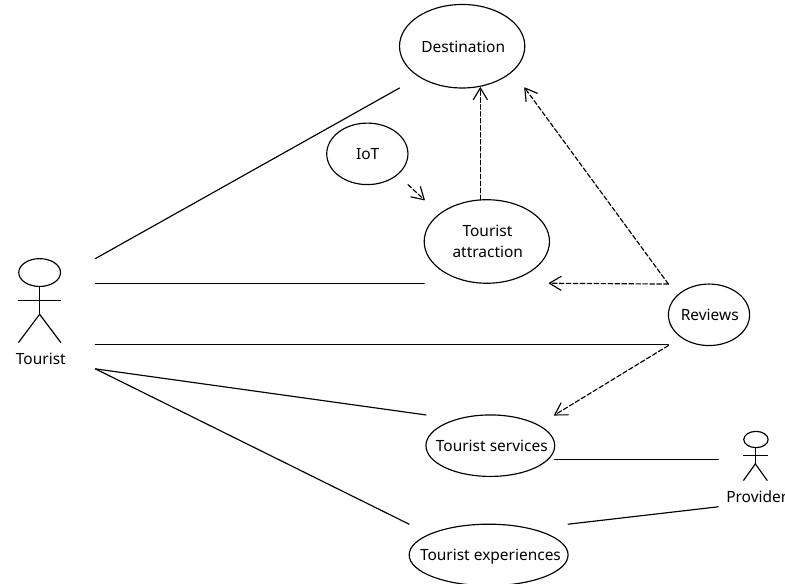
Figure 1. Tourist traceability system: use